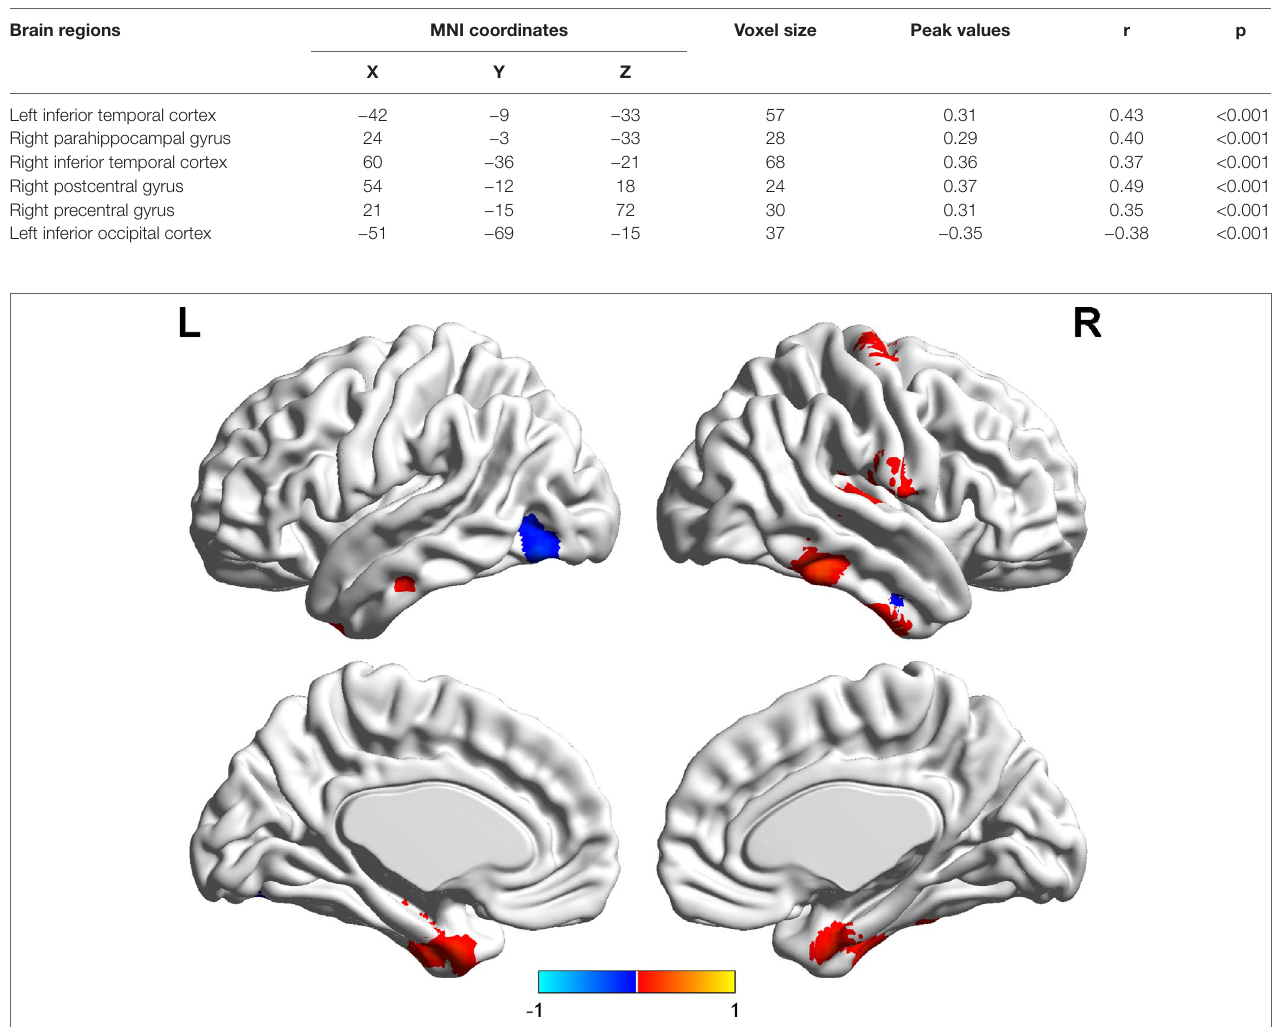
FIGURE 2 | Brain areas with significant correlations between the amplitude of low-frequency fluctuation (ALFF) and state anxiety.